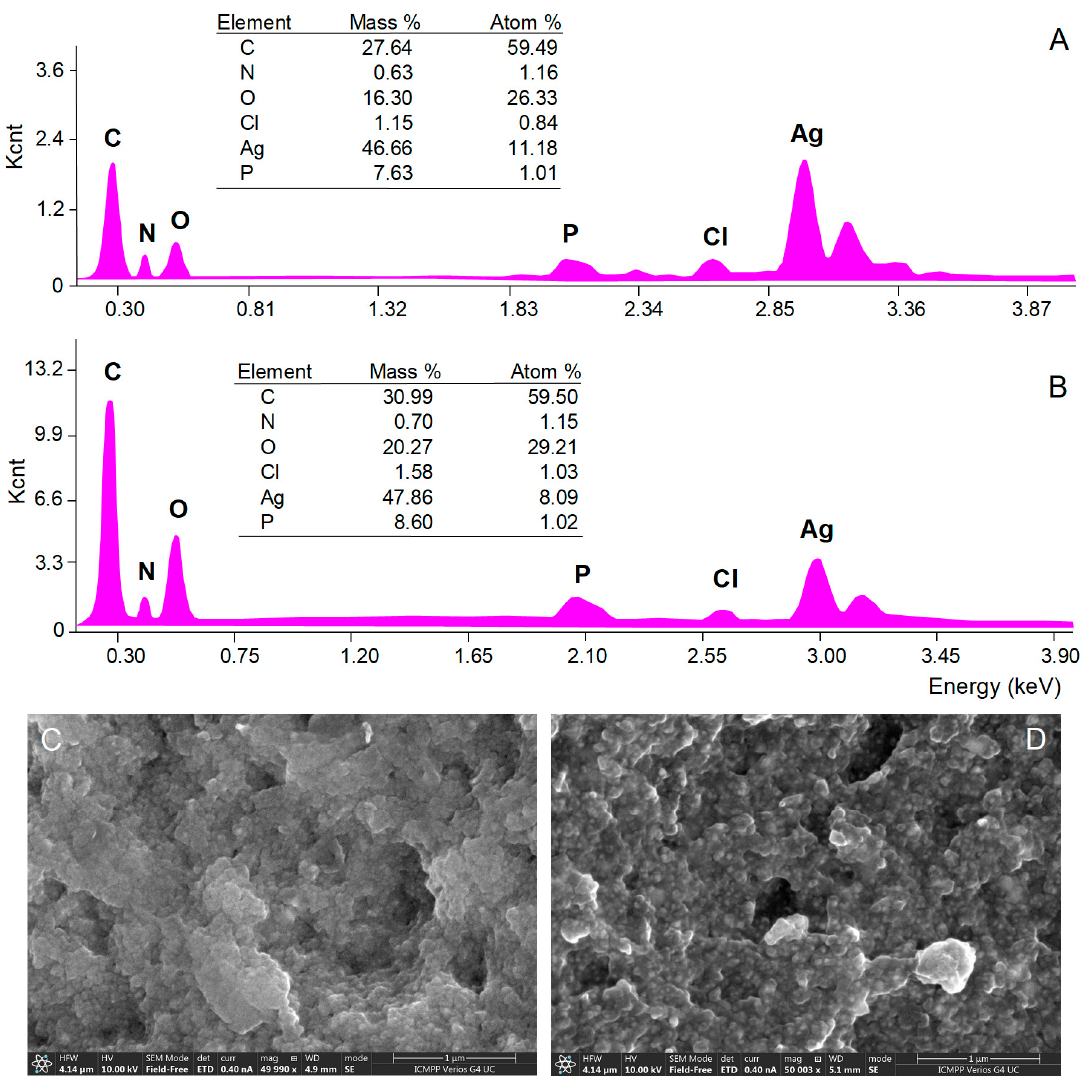
Figure 4. Elemental composition (EDX spectra) and SEM micrographs of Abies alba ( A , C ) and Pinus sylvestris ( B , D ) bark extract-derived AgNPs.